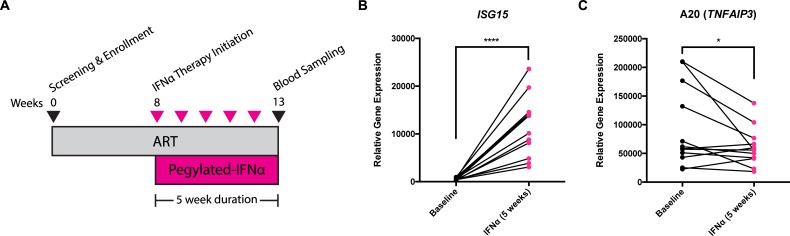
Five week pegylated-IFNα2a immunotherapy of ART-suppressed HIV-infected individuals leads to reduction in A20 expression.(A) Schematic showing duration and frequency of pegylated-IFNα2a administration in participants. Transcript levels of (B) IFN-stimulated gene ISG15 and (C) A20 in PBMCs at baseline and after five weeks of IFNα treatment as assessed by qPCR. Statistical significance was determined by paired t-test. * P<0.05, ****P≤0.0001.